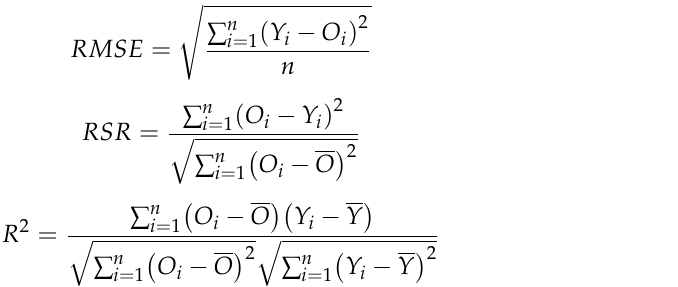
Figure 4. Rating curve considering the backwater effect based on 38 measured data points.